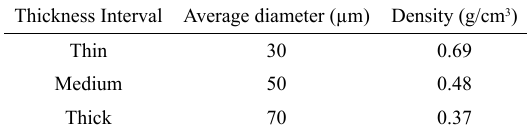
Table 1. Density of guaruman fibers for different diameter